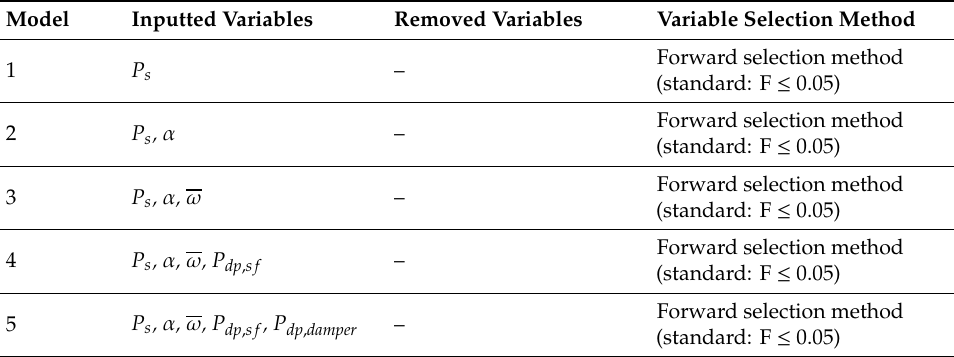
Table 5. Inputted and removed variables in the models.